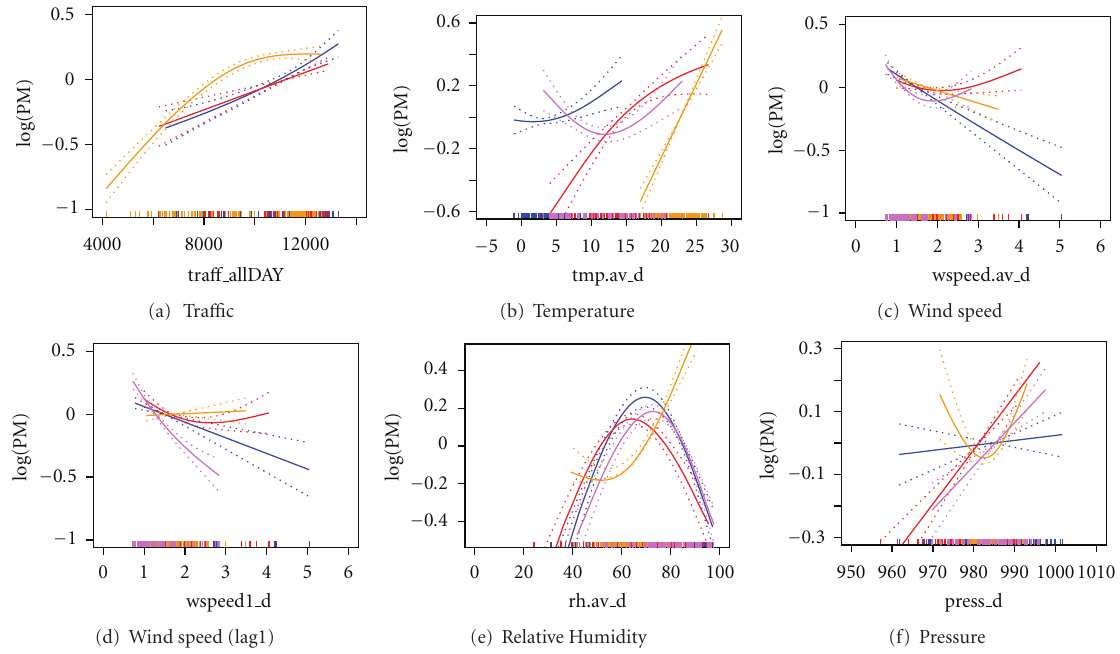
Figure 10: Estimated e ff ects of meteorological variables for PM 10 , by season. Blue is Winter, red is Spring, orange is Summer, and violet is